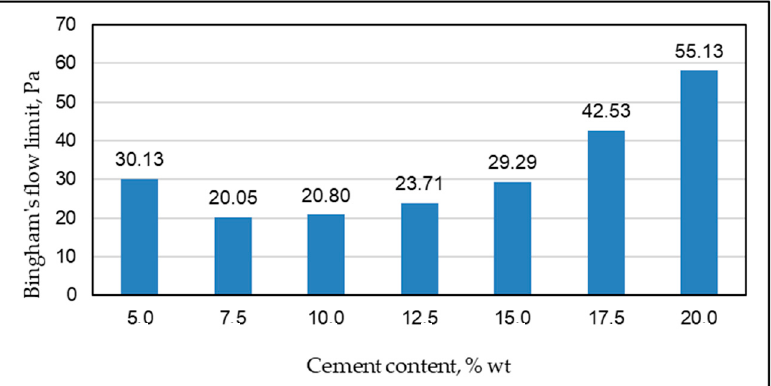
Figure 4. Values of the Bingham flow limit for suspensions prepared on the basis of smectite-type clay.